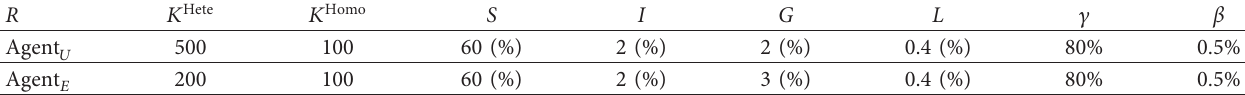
Table 3: Values of model